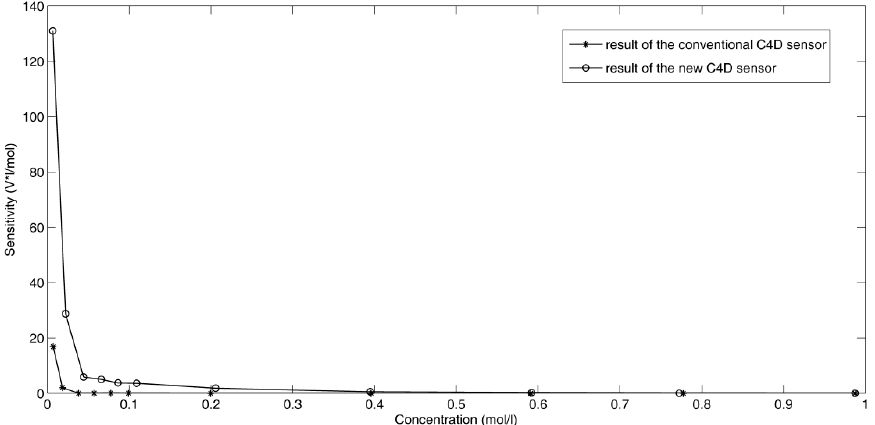
Figure 7. Sensitivity plots of the new C 4 D sensor with 3.0 mm i.d. and the conventional C 4 D sensor with 3.0 mm i.d.